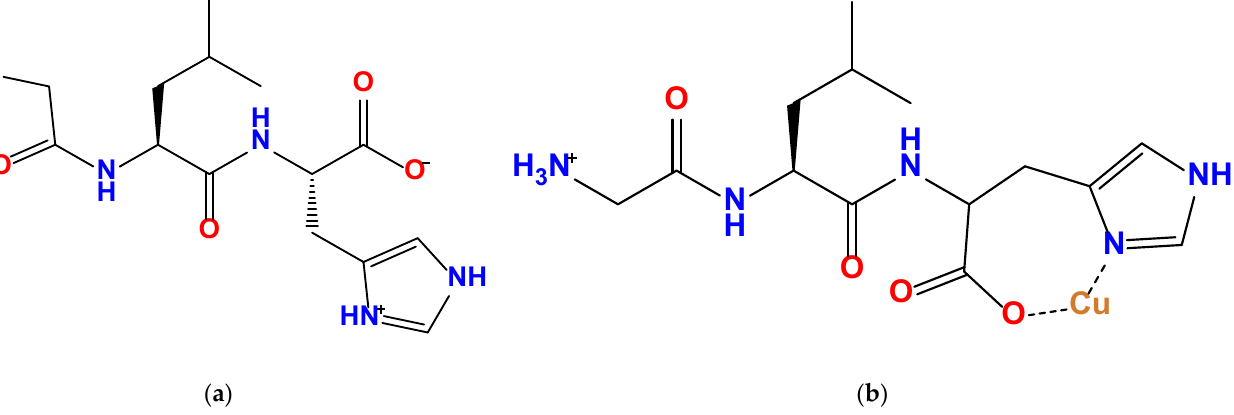
Figure 2. The two coordination modes ( a ) with an amine-N and carbonyl-O coordination and ( b ) with an imidazole-N and carboxyl-O coordination for the MLH species of GLH. The ML species of Cu-Sar-LH occurs at a higher pH than MLH, and so it is most likely that copper(II) only coordinates via the amine route and not via the imidazole ring, since the charge of the carboxylic acid moiety does not need to be neutralized at high pH values. Therefore, a possible coordination for the ML species is to the amine and neighboring amide-N with a protonated imidazole-N. The most likely mechanism in going from an MLH to ML species is for the sarcosine amide to switch from a carbonyl-O to an amide-N coordination, while the imidazole-N remains protonated. The transition from MLH to ML gives a p K a value of 4.99, which is a value typical of a metal-assisted amide deprotonation. The proposed switch has been seen in the ML to MLH -1 species of Cu-di, tri and tetraglycine [33,34]. These ligands have p K a values of 4.23, 5.41 and 5.56, respectively, and represent the first amide deprotonation. Additionally, a Cu-GGG complex [34] showed that the neighboring carbonyl-O could also be involved in the coordination. Therefore, the two possible coordination modes for the ML species (Figure 3) could be a bidentate coordination consisting of the amine and neighboring amide-N with a protonated imidazole-N, or a tridentate coordination consisting of the amine, neighboring amide-N and the carbonyl-O, with a protonated imidazole-N.